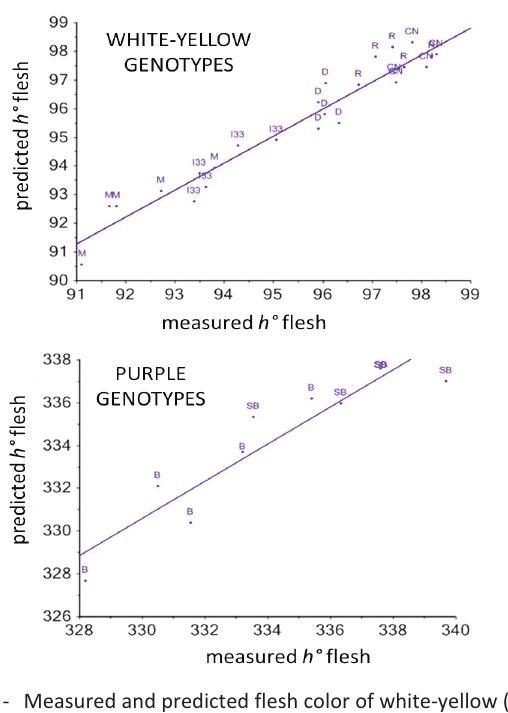
Fig. 2 ­ Measured and predicted CAR (top) and ANT (bottom) contents by PLS regression analysis.